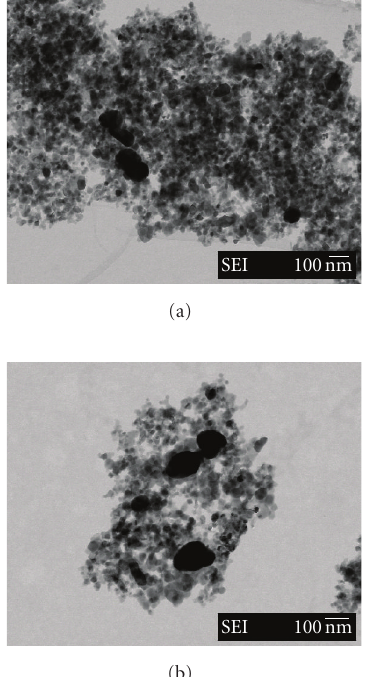
Figure 15: TEM images of 0.2 Ag-TiO 2 photocatalyst (a) before and (b) after